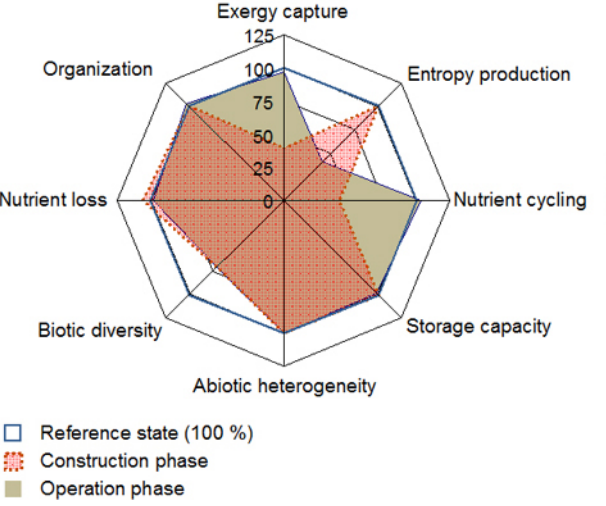
Fig. 4 . Synoptic overview of ecosystem development related to different phases of offshore wind farm (OWF) installations in the German North Sea. The reference state (the German North Sea without OWF) is indicated by 100%, alterations during construction and operation of wind farms are indicated by relative deviations (in %) from these reference values (based on Burkhard et al. 2011 a